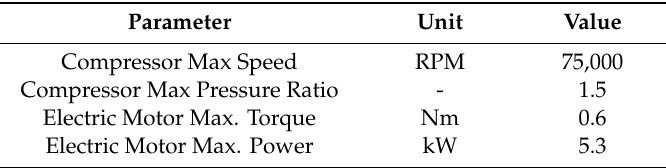
Table 5. Specifications of the 48 V eSupercharger